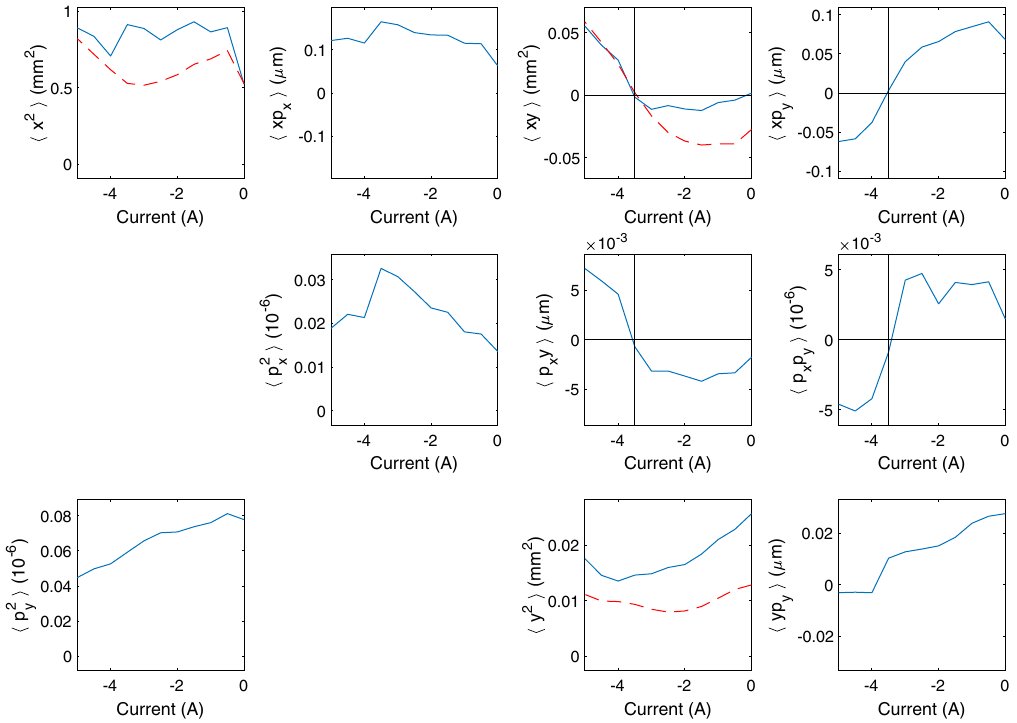
FIG. 12. Elements of the covariance matrix at SCR-02 (the reconstruction point) as functions of current in the bucking coil. Blue solid lines show the values determined from four-dimensional phase space tomography; red dashed lines show the values calculated from the directly observed image of the beam on SCR-02. Note that in the case of the tomography analysis, the elements describing coupling between the transverse degrees of freedom (shown in the top right 2 × 2 block diagonal) vanish for a bucking coil current of approximately − 3 . 5 A: this is consistent with the current at which the difference between the normal mode emittances is minimized (as shown in Fig.